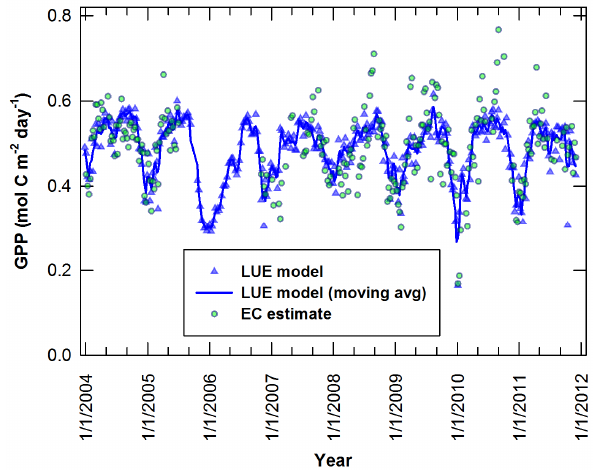
Fig. 9. Eight-day averages of EC-estimated and MVP-LUE modeled GPP (LUE*PAR) and 3-period moving average of modeled GPP during 2004-2011.